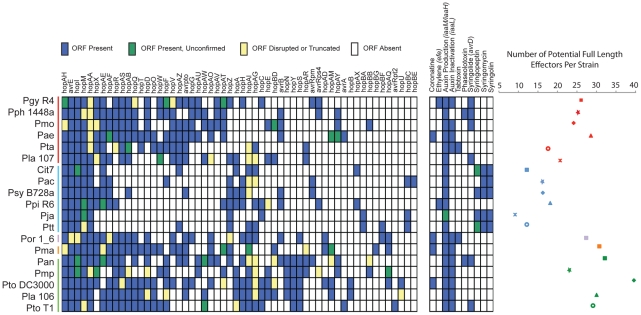

P. syringae isolates harbor extensive diversity in virulence gene repertoires.TTE, toxin, and plant hormone biosynthesis genes are listed across the top, P. syringae genomes, color-coded by phylogenetic group as in Figure 1. At the left, a blue box indicates presence of full-length ORFs or complete pathways within each genome. Green boxes indicate that genes or pathways are present by similarity searches, but the presence of full-length genes could not be verified by PCR, or the pathways are potentially incomplete. Yellow boxes indicate that genes are either significantly truncated or are disrupted by insertion sequence elements. White boxes indicate absence of genes or pathways from the strains based on homology searches. At the far right, the total number of potentially functional TTE proteins is shown for each genome and displayed according to the color-coded strain and group symbols shown in Figure 1.